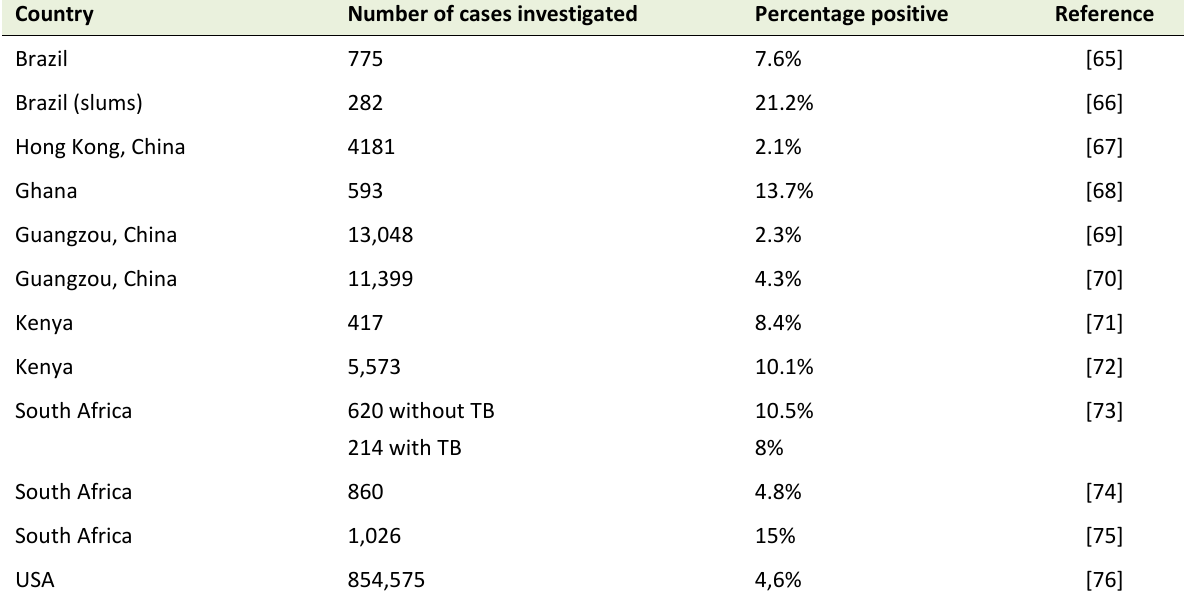
TABLE 1 . Respiratory tract infections with non-SARS coronaviruses.